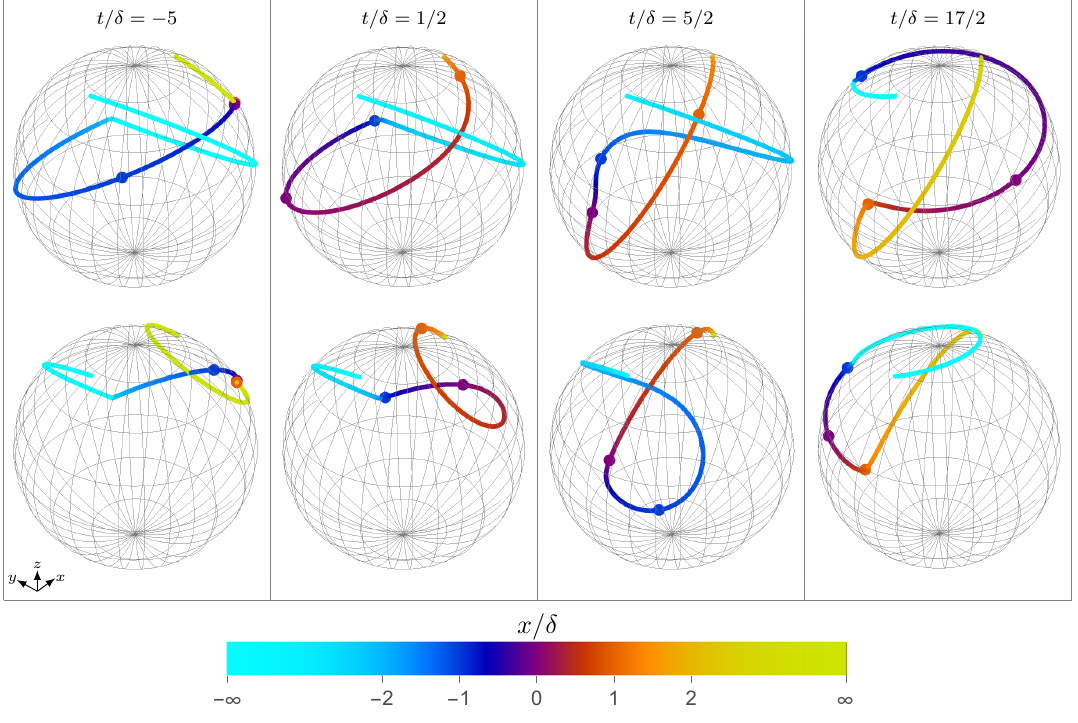
Figure 3 . Time evolution of the three-soliton solution with initial data (6.36) I: spatial dependence of u ( x, t ) (upper spheres) and v ( x, t ) (lower spheres) at four instances of time t , with colours indicating the position x according to the legend on the bottom. Note that the color gradient is non-linear, changing linearly only close to the origin x = 0 but approaching a constant color away from the origin exponentially fast. For three distinguished points x = x = 1 (red) on the x -axis, we have indicated the corresponding spins with a dot. The orientation of all plots is the